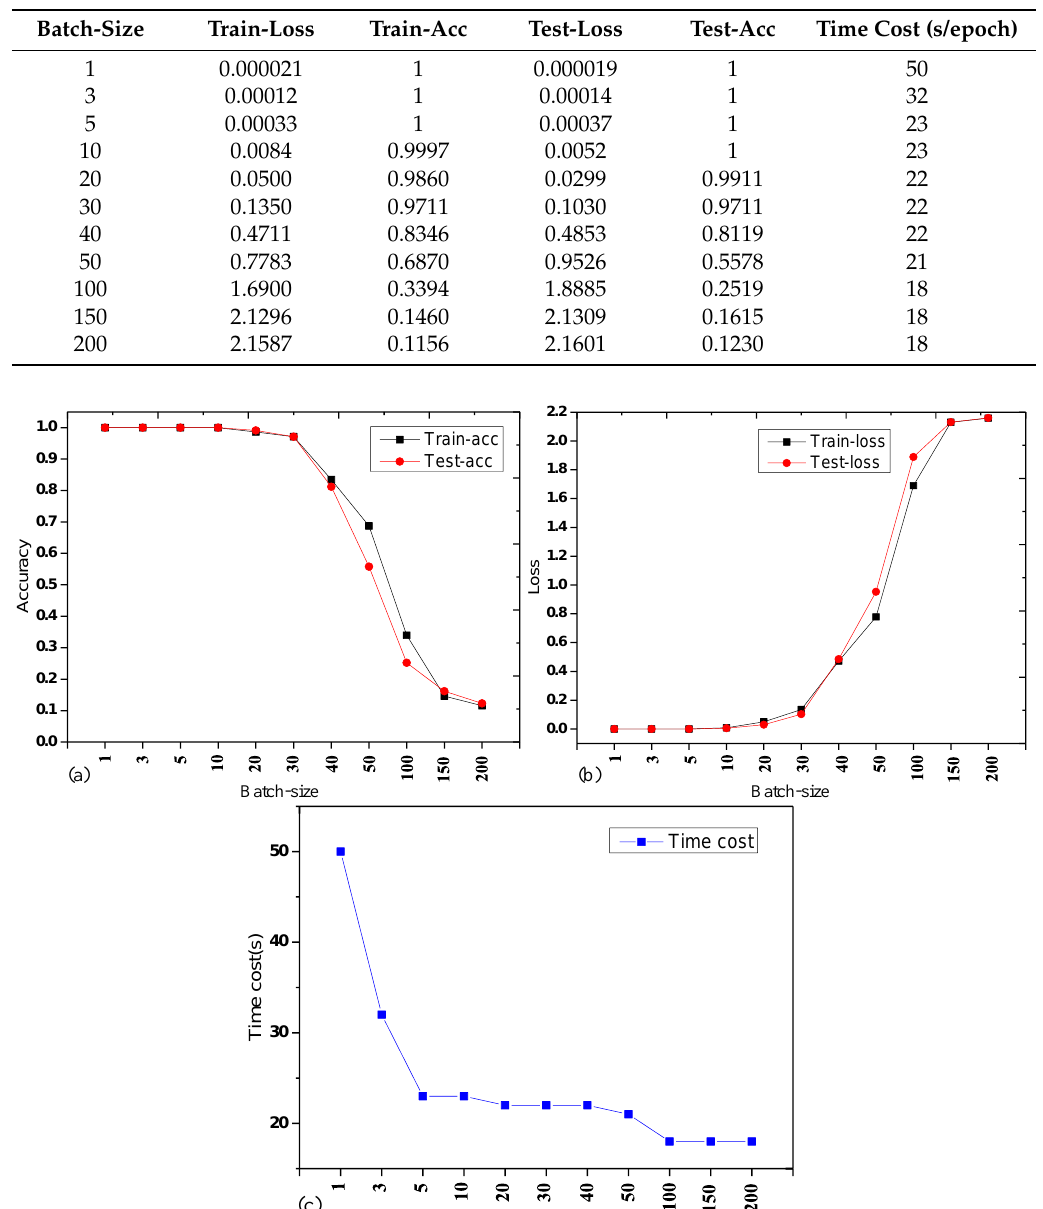
Table 6. The loss, accuracy, and time cost under different batch-sizes.